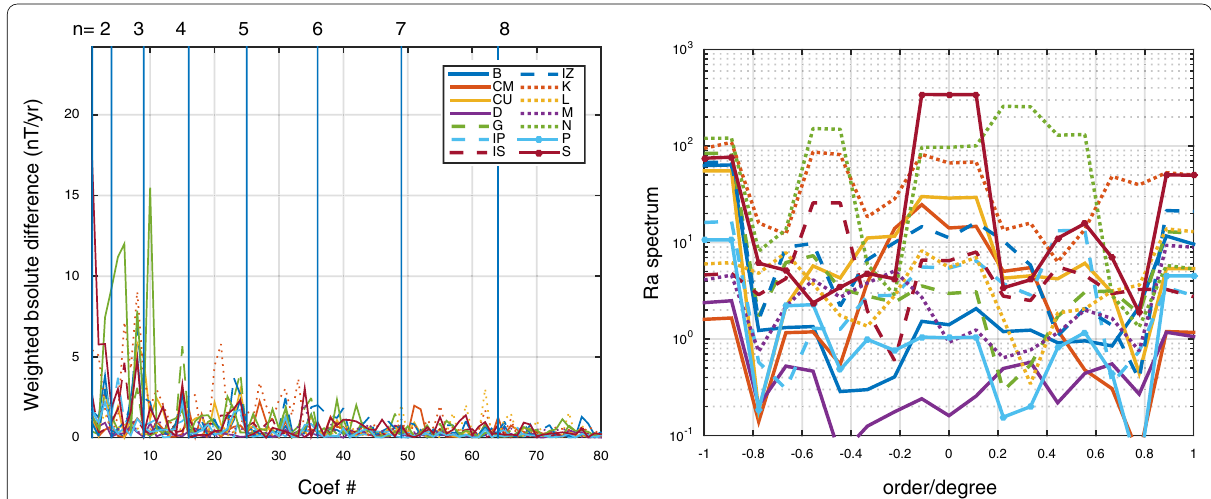
1 (left) and azimuthal power spectrum difference (right) between the +